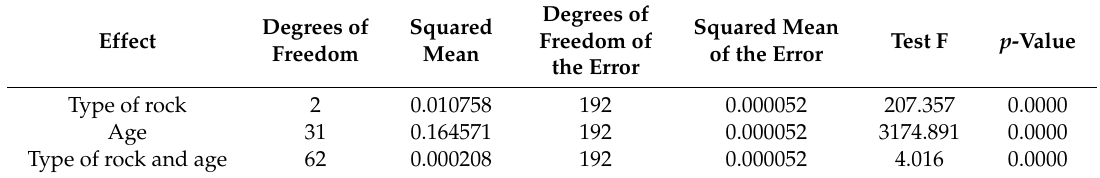
Table 6. Analysis of the variance of the effects to the expansions of the ASTM C 1260